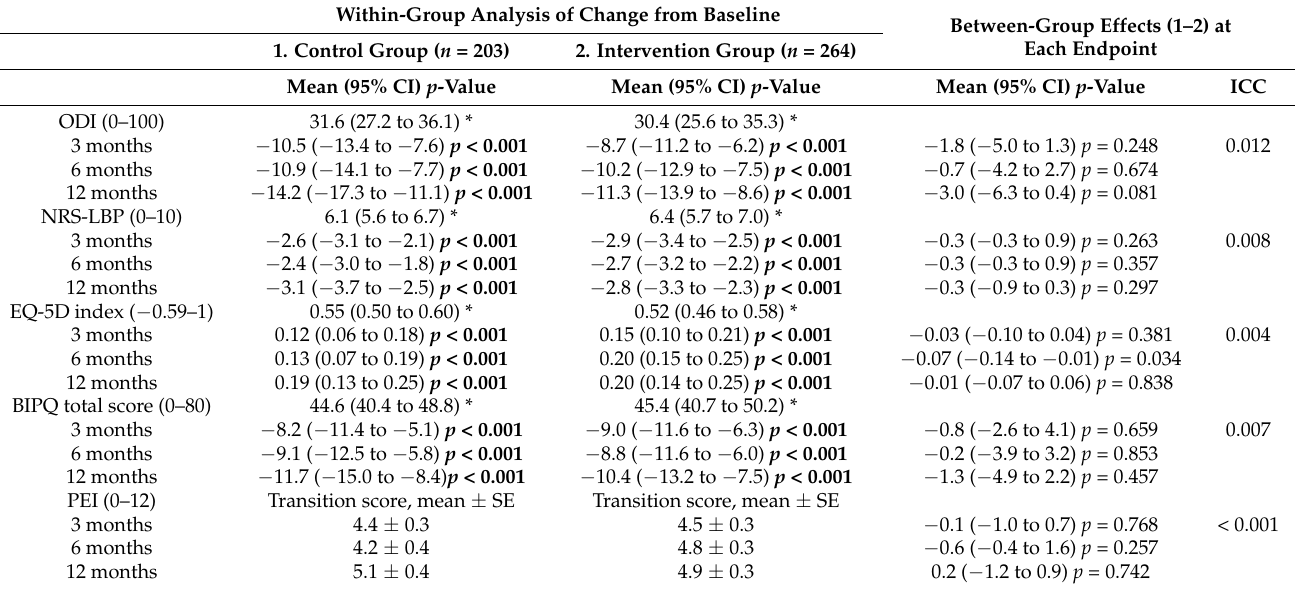
Table 4. Comparisons of patient reported outcome measures in control and intervention group. Within-Group Analysis of Change from Baseline